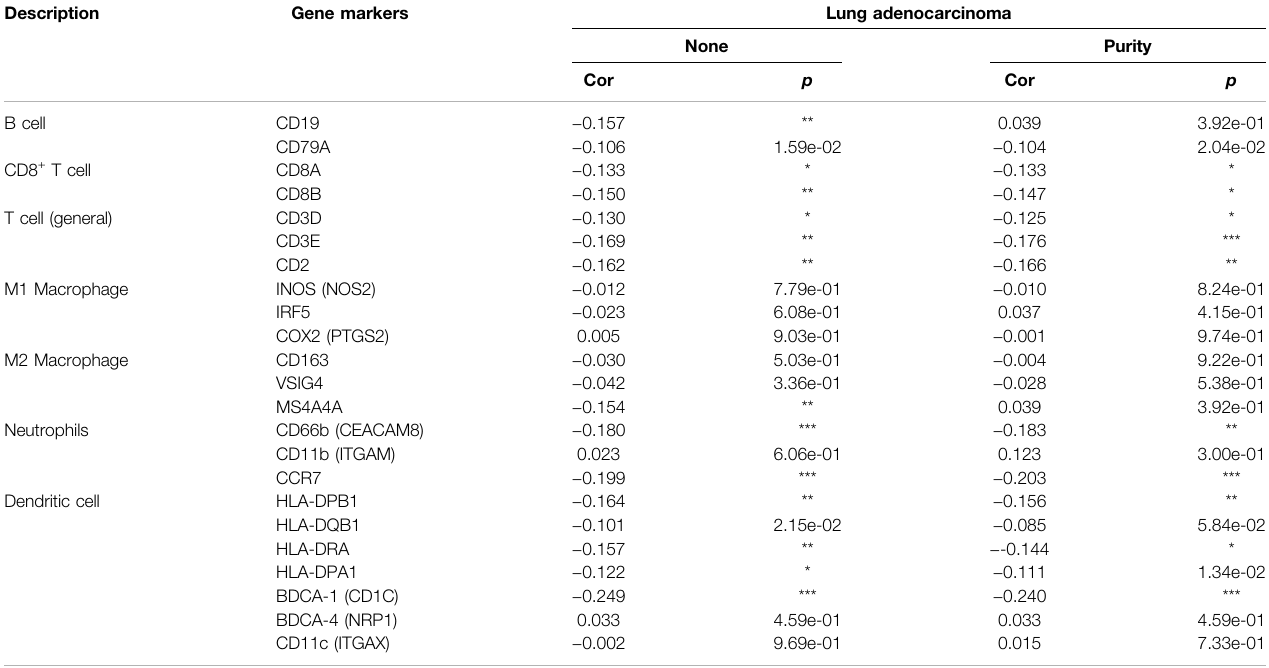
TABLE 3 | Correlation analysis between ALDOA and immune in fi ltration markers in TIMER.